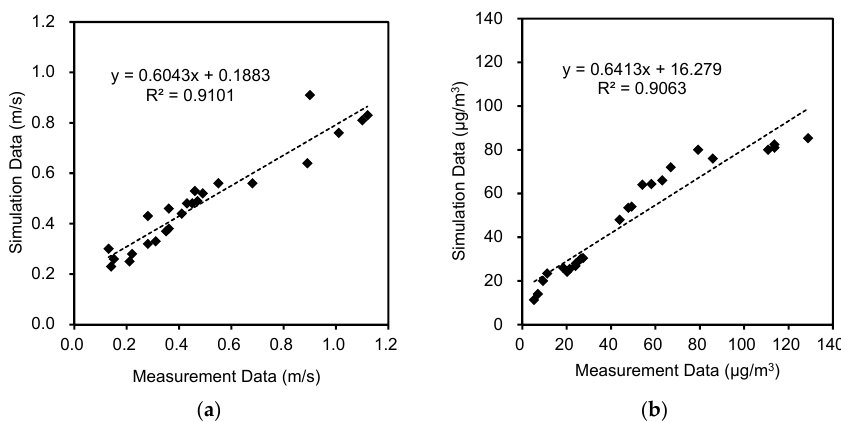
Figure 3. Model validation: comparison of the simulation results and measurement data for wind velocity ( a ) and PM 2.5 ( b ).